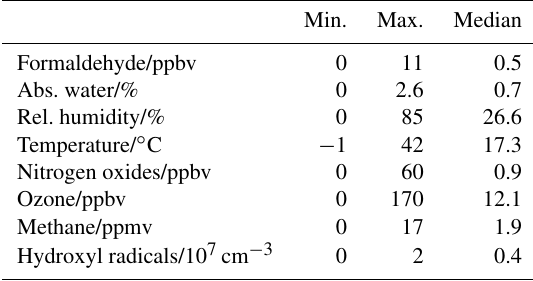
Table 2. Range of conditions inside the SAPHIR chamber during the period between June 2019 and December